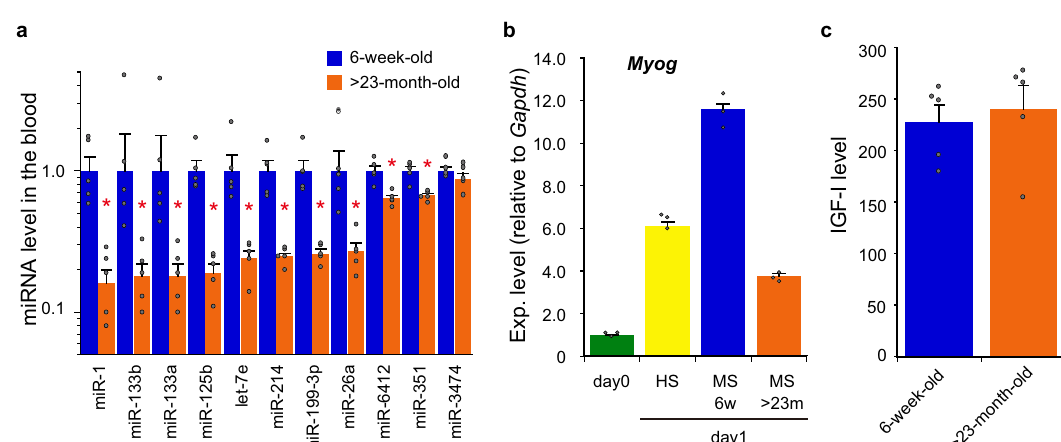
Fig. 1 Blood-circulating substances in young and aged mice. a Cell-free miRNAs (cf-miRNAs) circulating with blood in young and aged mice. RNA was isolated from the plasma of young (6-week-old) and aged (>23-month-old) C57BL/6J mice, and miRNAs (indicated) were examined by qRT-PCR. The data were analyzed by the delta – delta Ct method using the data of cel-miR-39 as an external control and normalized with the data obtained from young mice as 1. Data are shown as mean ± SEM ( n = 5 mice; * p < 0.05 by Wilcoxon rank-sum test). b Myogenic differentiation with young and aged mouse serum. C2C12 cells were cultured for 24 h in following the differentiation media: DMEM supplemented with 5% young mouse serum (MS, 6w) or 5% aged mouse serum (MS, >23m), and DMEM supplemented with 2% house serum (HS) as a conventional differentiation medium. Total RNA was extracted from the cells and undifferentiated C2C12 cells (day 0) as a control. The expression of Myog as a myogenic differentiation marker was examined by qRT-PCR and analyzed by the delta – delta Ct method, using the data of Gapdh as an internal reference. The data were further normalized with the data of undifferentiated cells (day 0) as 1. Data are shown as mean ± SEM ( n = 3 independent determinations). c IGF-I level in young and aged mouse blood. Plasma samples